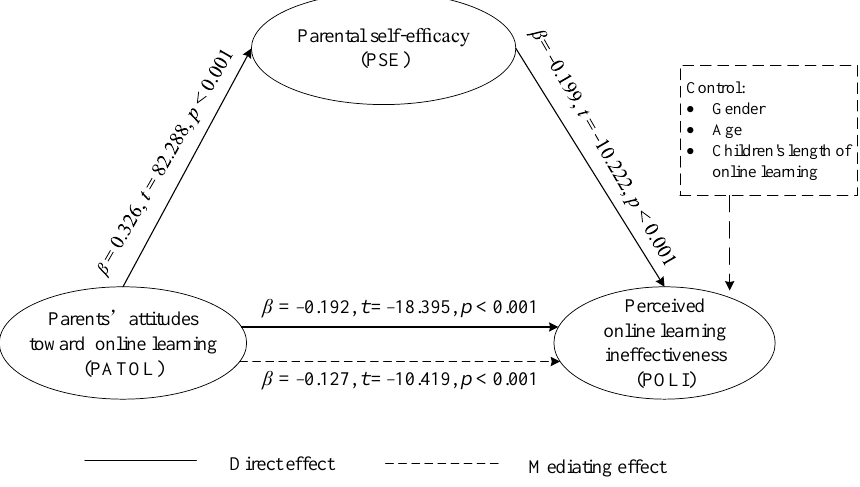
Figure 2. Mediating Role of Parental